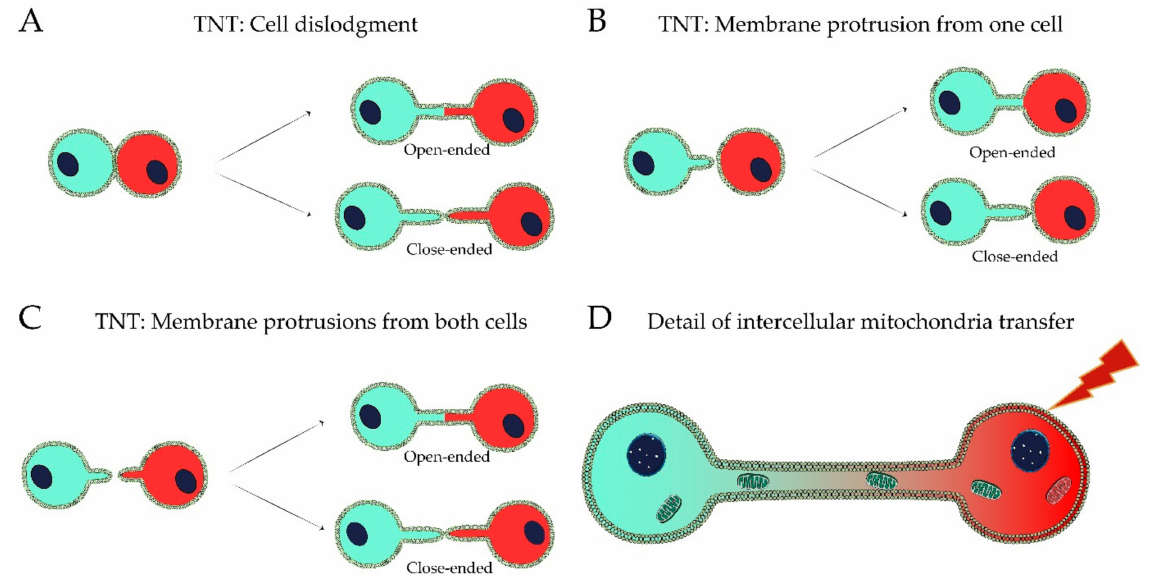
Figure 1. Mechanisms of formation of TNT and detail of intercellular mitochondria transfer. ( A ) TNTs can be formed by cell dislodgment, when cells are close together and move apart, creating TNTs that can be either open-ended or close-ended. ( B,C ) TNTs can occur by the extension of membrane protrusion(s) from one cell ( B ) or from both cells ( C ), and can be open-ended or close-ended. ( D ) Damage-inducing events can trigger the transfer of healthy mitochondria from healthy cells to damaged